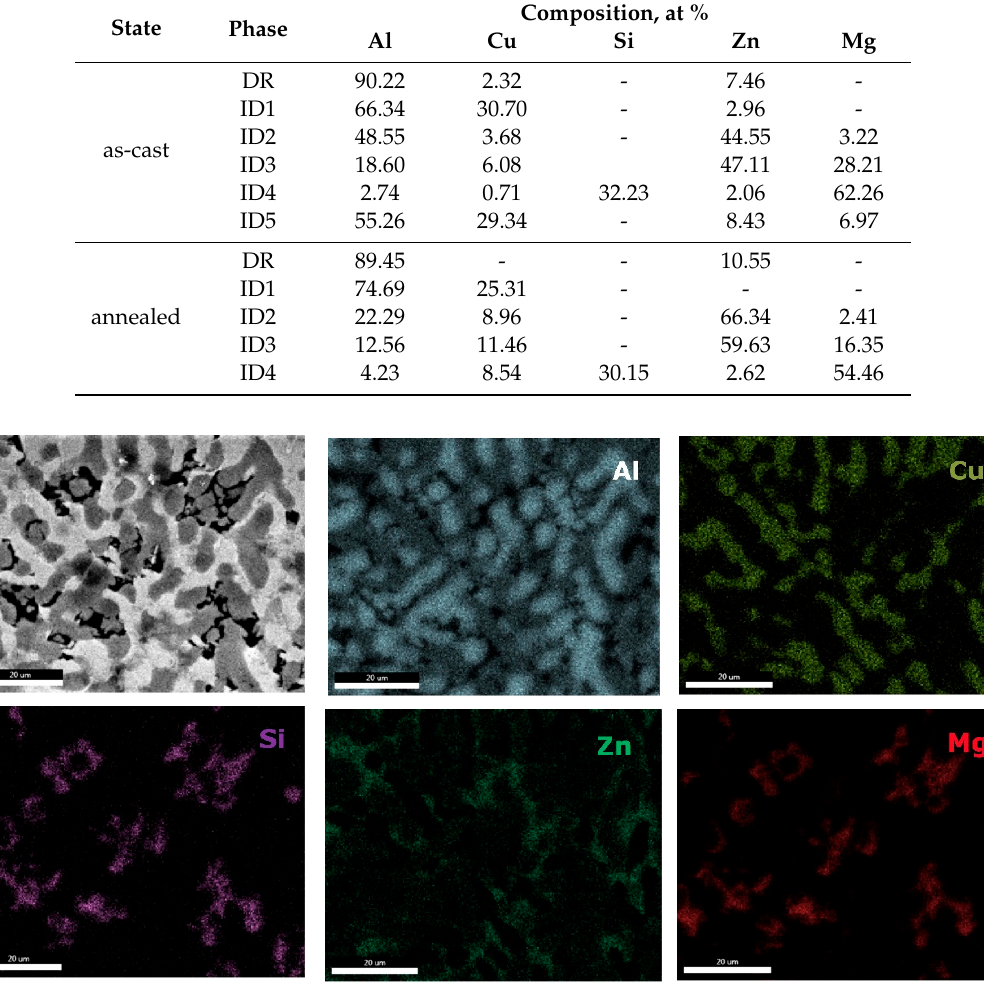
Figure 16. EDS mapping of as-cast Al 3.4 Cu 0.5 Si 0.2 Zn 0.5 Mg 0.2 alloy.